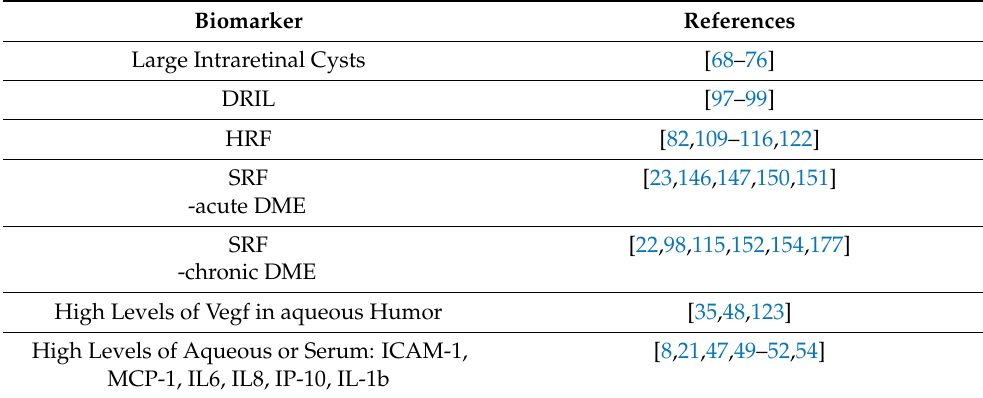
Table A2. Outlines of the references in respect to each individual